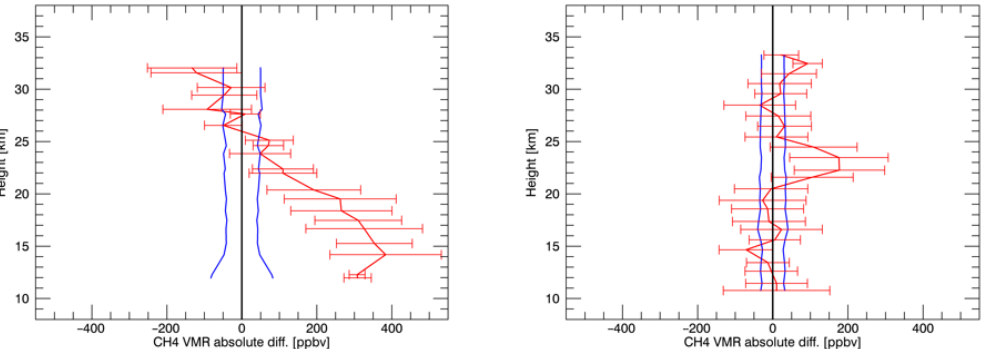
Figure 4. Left panel: CH 4 validation based on cryosampler (BONBON) flights B39, B40, and B41 (high spectral resolution). Red line: interpolated mean difference between MIPAS-E and cryosampler mixing ratios. Red error bars: mean standard deviation of the difference between MIPAS-E and cryosampler mixing ratios for the respective altitude range. Blue line: interpolated mean error for CH 4 mixing ratio values from MIPAS-E database. Right panel: CH 4 validation based on cryosampler flights B42, B43, B45, and B46 (low spectral resolution). Red line: interpolated mean difference between MIPAS-E and cryosampler mixing ratios. Red error bars: mean standard deviation of the difference between MIPAS-E and cryosampler mixing ratios for the respective altitude range. Blue line: interpolated mean error for CH 4 mixing ratios from MIPAS-E